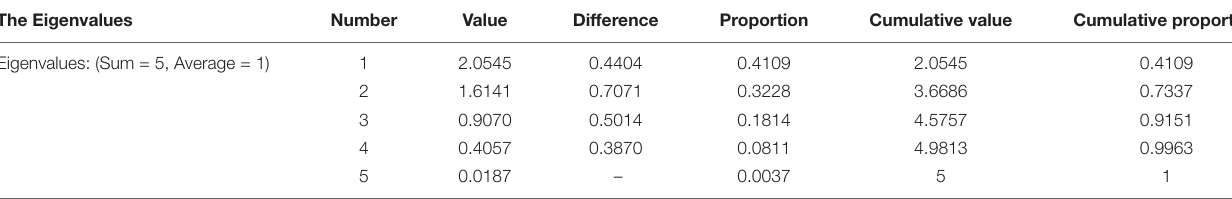
TABLE 1 | Principle component analysis (PCA) of the variables (China). The Eigenvalues Number Value Difference Proportion Cumulative value Cumulative proportion Eigenvalues: (Sum = 5, Average = 1)